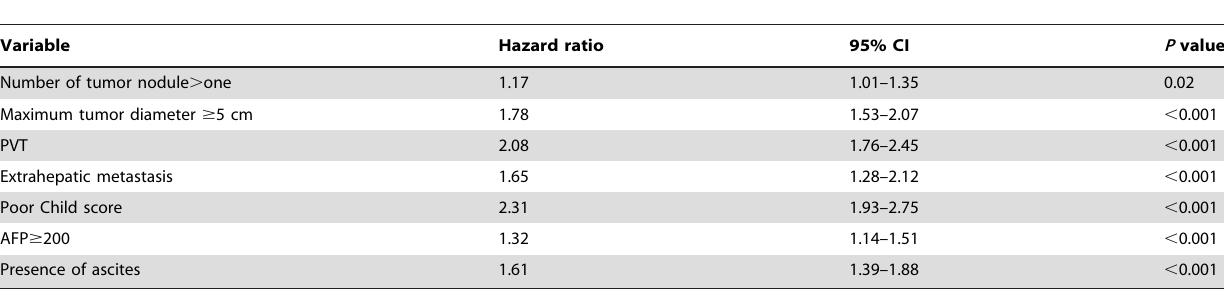
Table 4. Multivariate analysis of baseline predictors of survival.